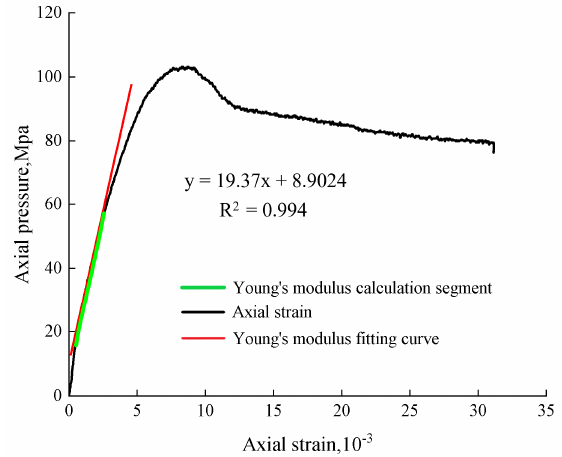
Figure 9. Variation curve of Young’s modulus of typical core.